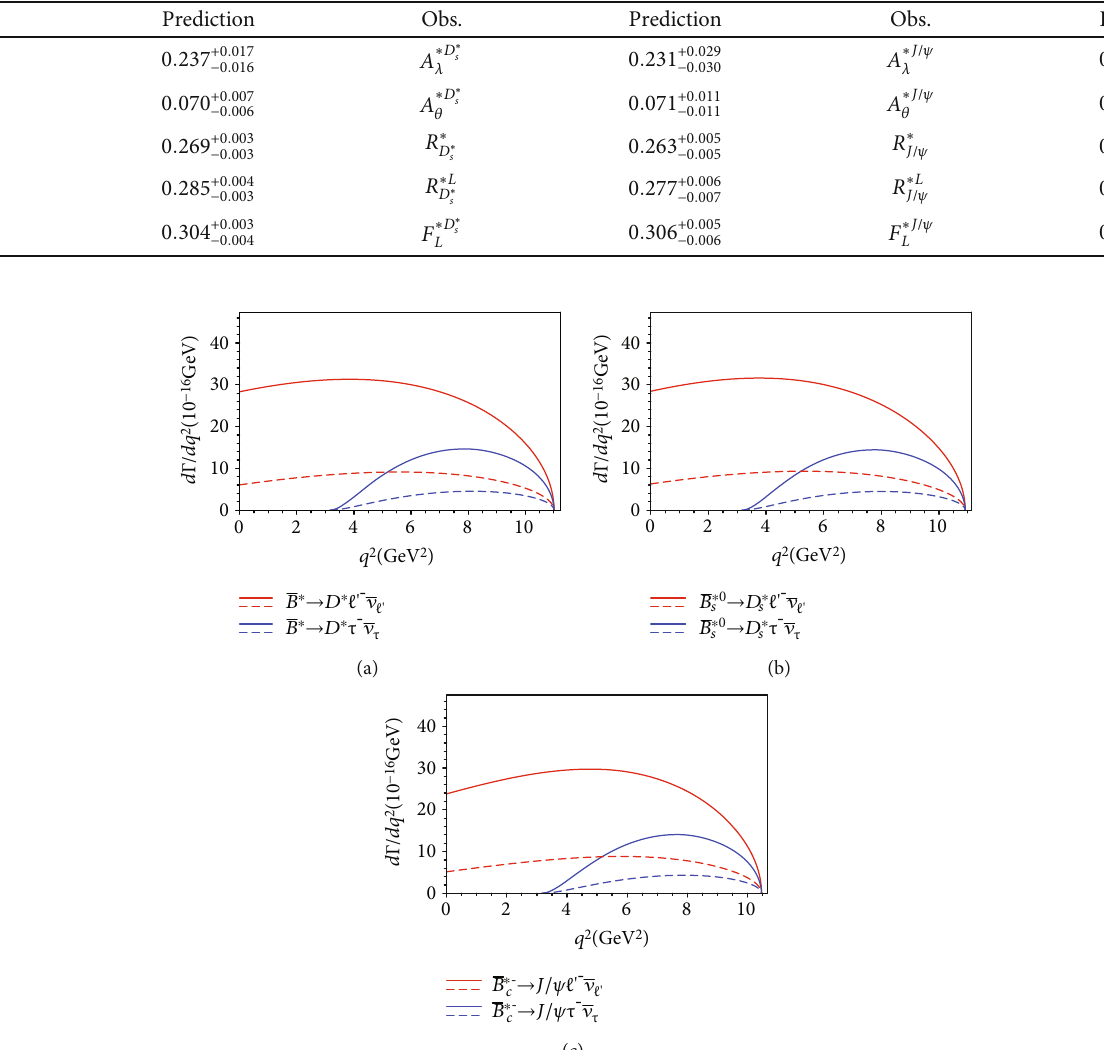
ð ℓ = τ Þ , R ∗ ð L Þ , and F ∗ V . λ , θ V L